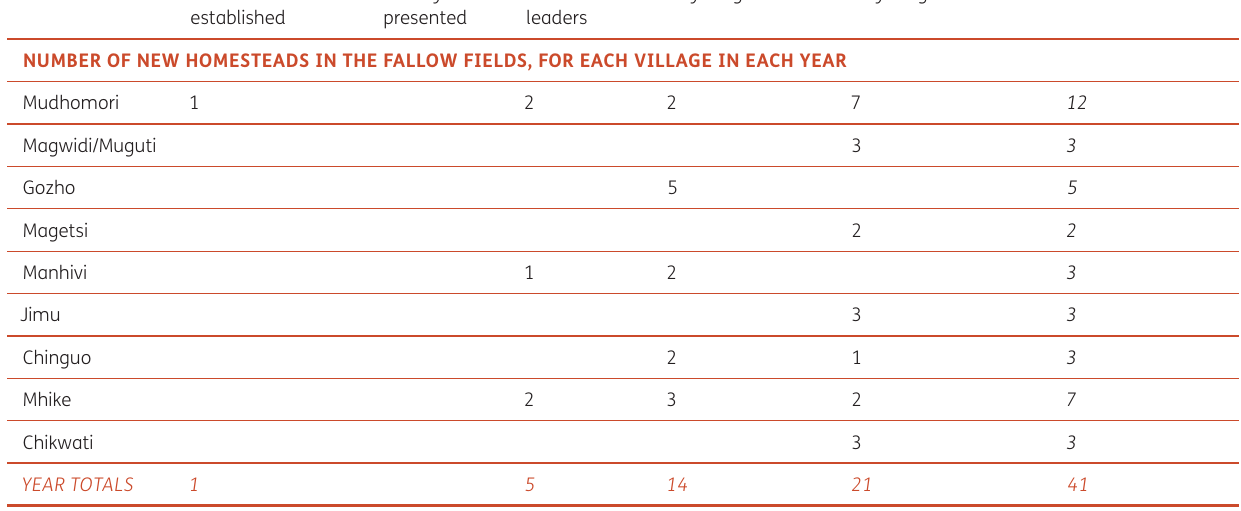
Table 3 Spread of land-use policy innovation in Mazvihwa Communal Area (villages are listed in order of roughly increasing distance from Mudhomori).